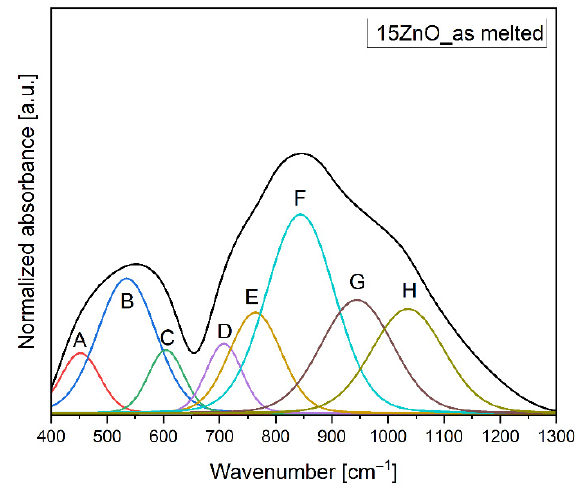
Figure 3. MIR spectrum of the 15ZnO glass co-doped with Ni 2+ and Er 3+ .